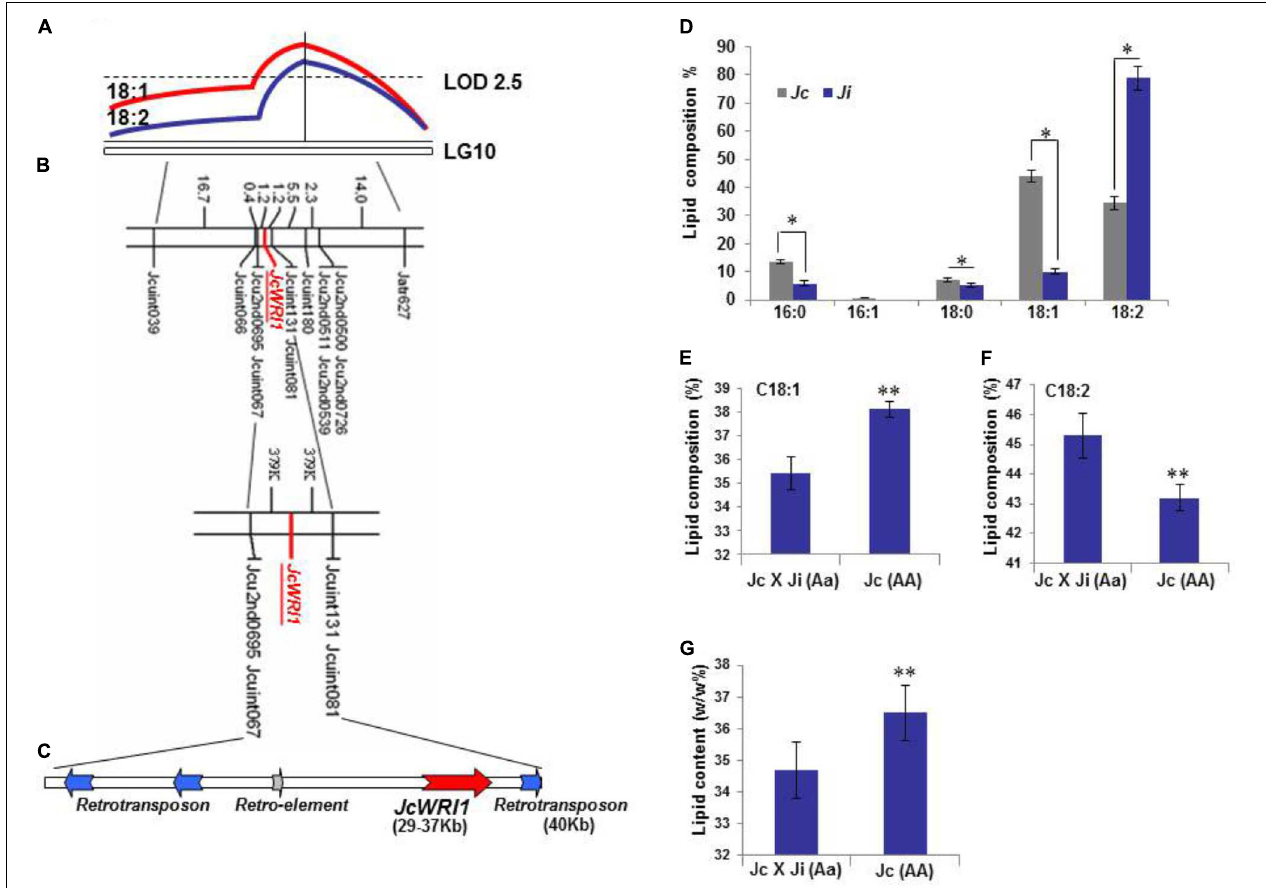
FIGURE 1 | JcWRI1 is located in a QTL underlying high-oleate seed lipid on LG10 in Jatropha . (A) A high oleate level QTL ( qHO10 ) with LOD 4 on LG10 was detected in the region harboring JcWRI1 . Horizontal line indicates 5% LOD significance threshold (2.5) based on permutation. The QTL has a strong effect on seed oleate (C18:1) levels and negative effect on seed linoleate (C18:2) acid levels. (B) Fine mapping of the JcWRI1 locus. (C) A 40 kb contig harboring JcWRI1 in qHO10 . This contig is rich in transposable element. (D) Lipid composition of mature seeds of J. integerrima and J. curcas. Values are mean ± SD ( n = 3) with statistical analysis using Student’s t -test ( ∗ indicates p < 0.05). (E) Single point analysis shows a higher seed oleate (C18:1) level in the Jc genotype (AA) than in the JcXJi (Aa) genotype. Values are mean ± SD ( n = 3) with statistical analysis using Student’s t -test ( ∗∗ indicates p < 0.01). (F) Single point analysis shows a lower seed